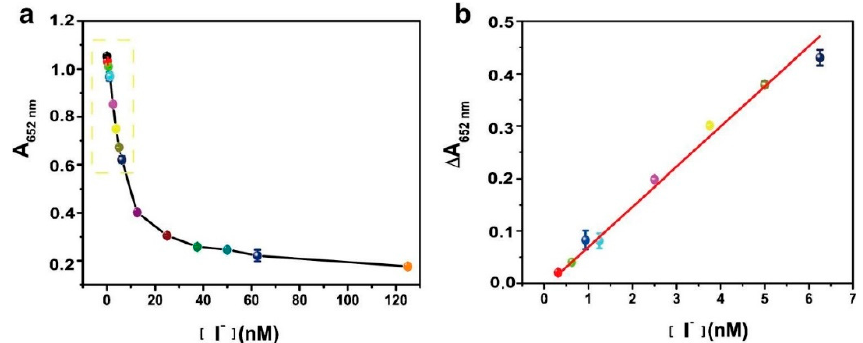
Figure 9. ( a ) Absorbance of TMB+H 2 O 2 +CC-PdNPs system at 652 nm in the presence of various concentrations of I − ; ( b ) The linear relationship for I − detection ( Δ A 652nm = A 0 − A). A 0 and A represent A 652nm of TMB+H 2 O 2 +CC-PdNPs system and TMB+H 2 O 2 +I − +CC-PdNPs system, respectively. Reprinted with permission from Ref. [144]. Copyright 2020 Springer.